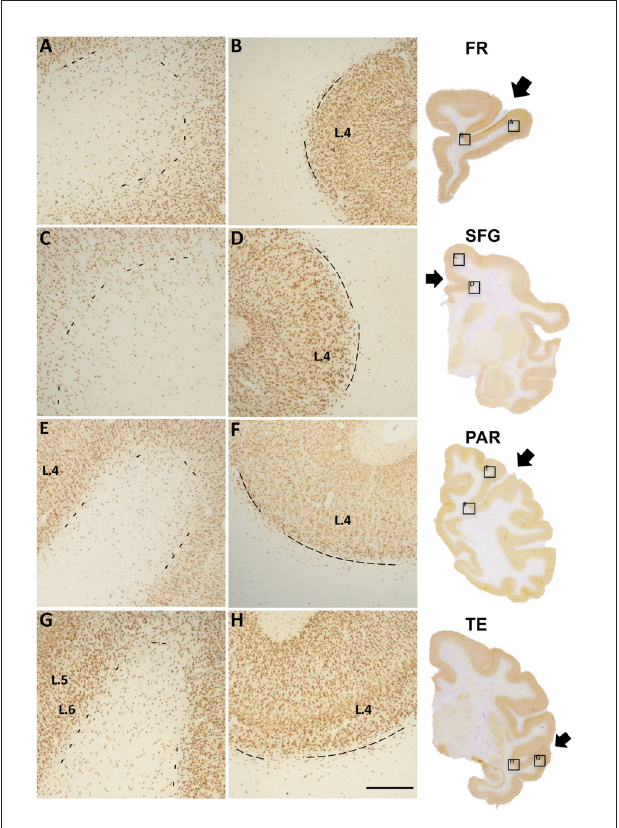
FIGURE 1 | Photomicrographs of Neu-N labeled white matter neurons (WMNs) in the gyral crown (A,C,E,G) and corresponding sulcal depth (B,D,F,H) in the frontal (A,B) , cingulate/superior frontal gyrus (SFG) (C,D) , parietal (E,F) and temporal regions (G,H) . The border between layer 6 and the subjacent WM is indicated by dashed lines. Coronally sectioned histological sections (at right) indicate approximate AP level and location of the gryal and sulcal photomicrographs (in boxed locations). Short arrows, from top to bottom, point to principal sulcus, cingulate sulcus, intraparietal sulcus (IPS) and superior temporal sulcus (STS). L = layer, Scale bar = 500 µ m (A–H)